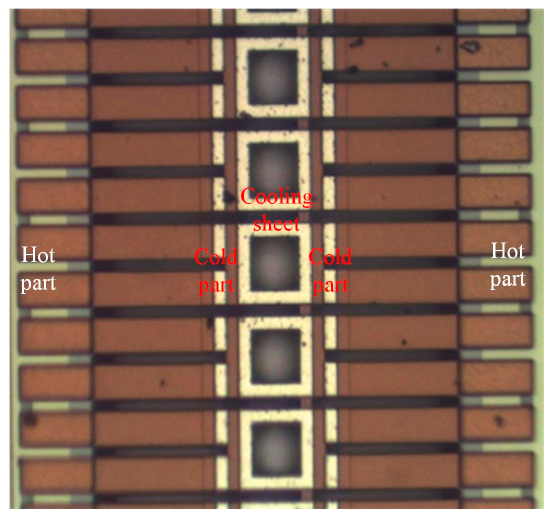
Figure 11. A partial image of the TEMH taken by an optical microscope.